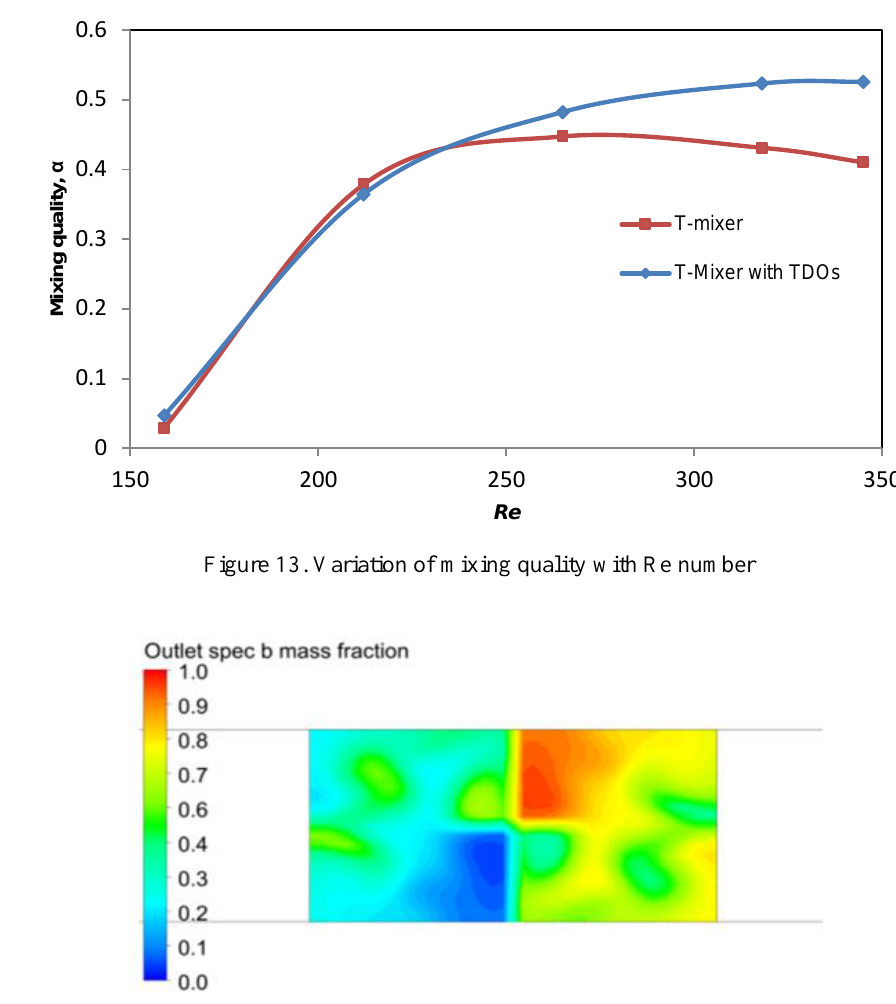
Figure 14. Outlet mass fraction contour of T-mixer with TDOs at Re = 345